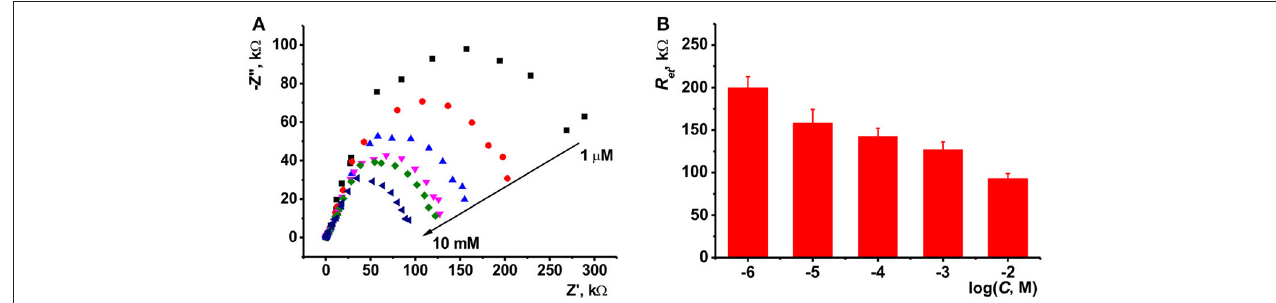
Frontiers in Chemistry |